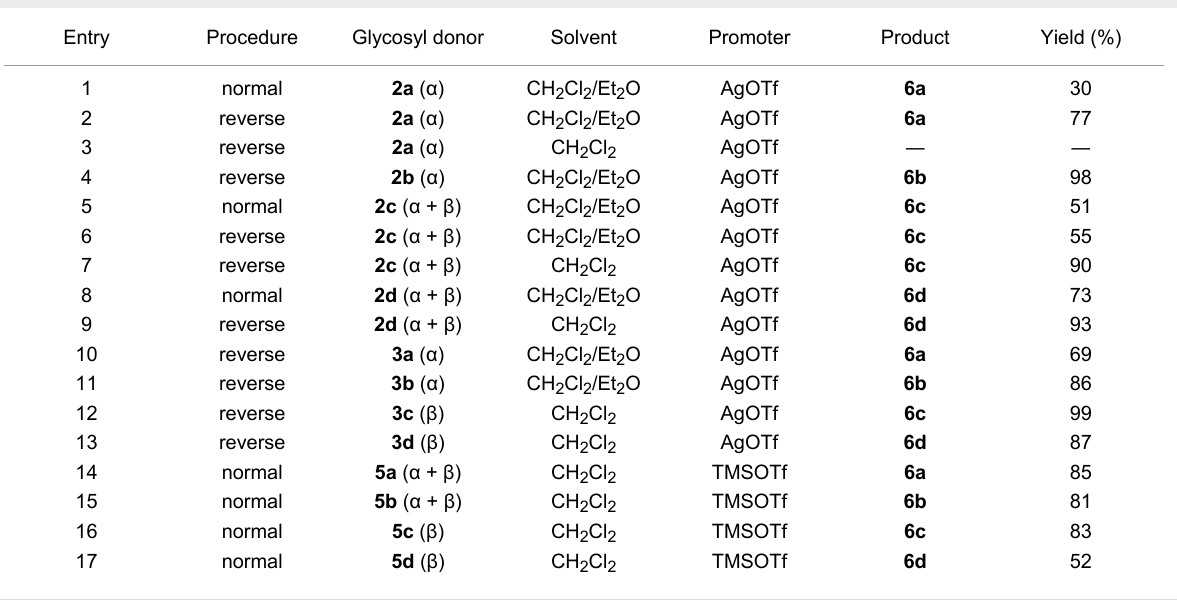
Table 1: Procedures and results concerning diosgenin